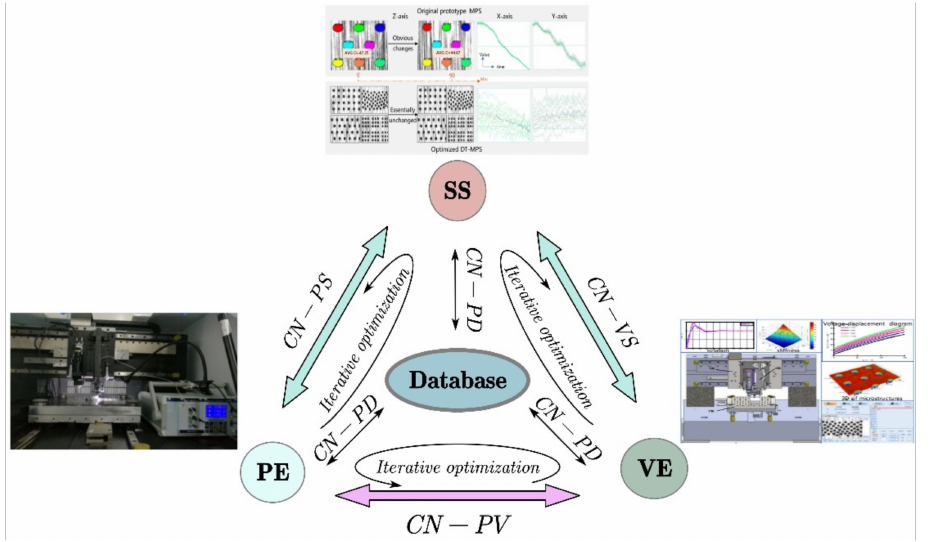
Figure 14. The framework of DT system